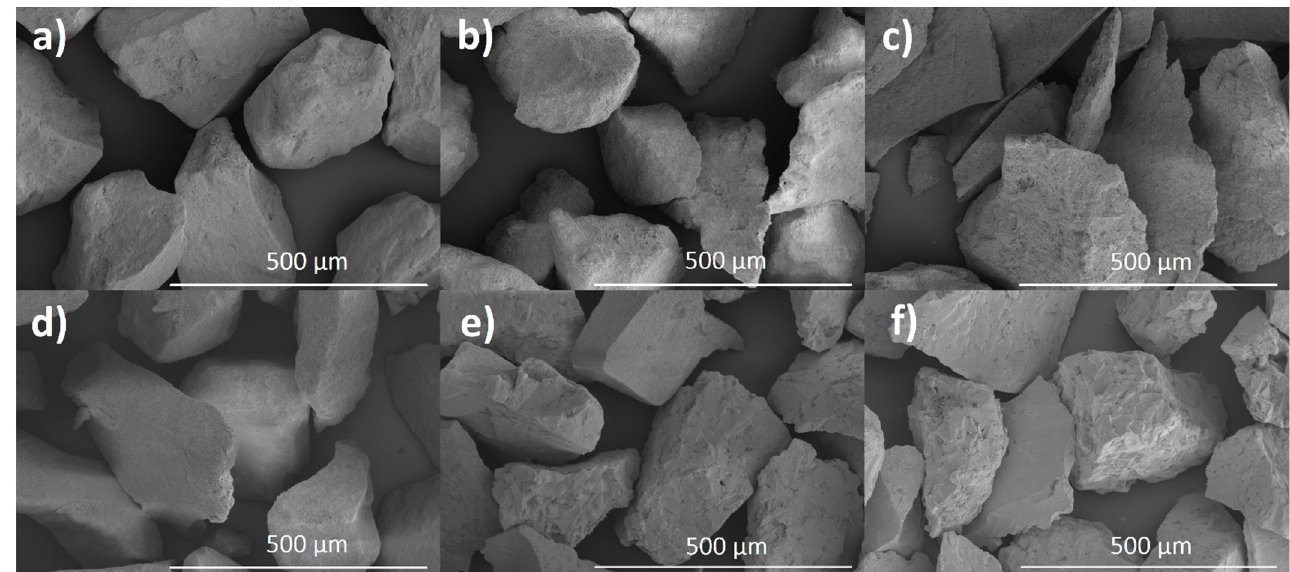
Figure 3. SEM pictures of ( a ) HAP-800, ( b ) HAP-1000, ( c ) HAP-1200, ( d ) FAP-800, ( e ) FAP-1000, and ( f )